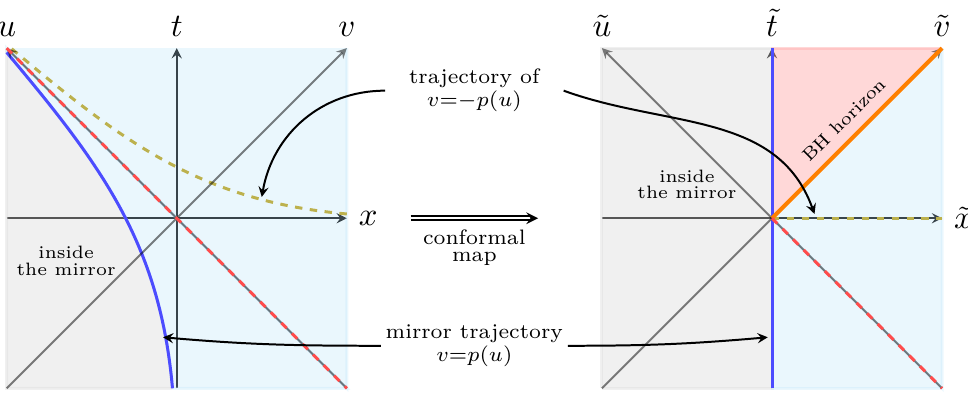
Figure 5 . A moving mirror model in the ( t, x ) -coordinate [Left] and in the tilde coordinates [Right]. A CFT lives outside the mirror v ≥ p ( u ) ( x ≥ z ( t ) ), which can be mapped to the RHP by a conformal transformation. The red region (˜ x ≥ 0 , ˜ t ≥ ˜ x ) in the right panel has no counterpart in the original coordinate system and can be seen as a black hole